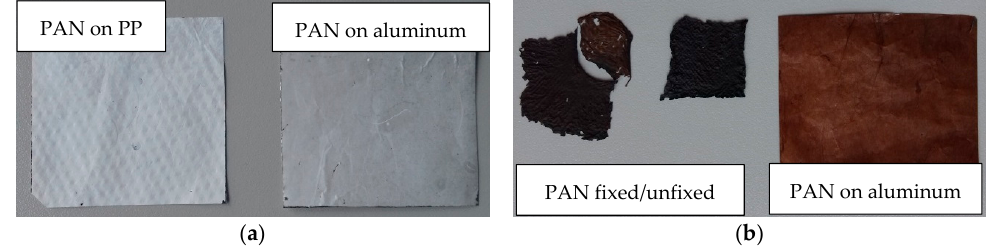
Figure 3. PAN nanofiber mats electrospun on different substrates: ( a ) after spinning; ( b ) after stabilization (and separating from the substrate in case of the PP substrates) at 280 °C for 1 h.